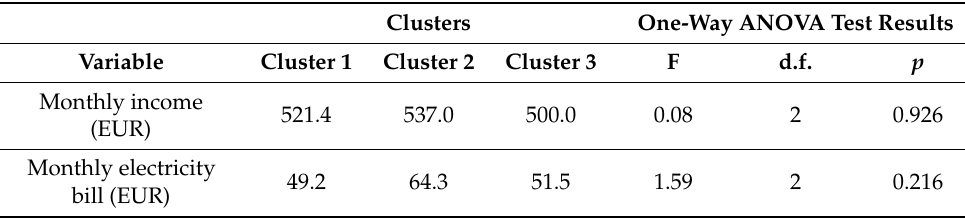
Table 7. One-way ANOVA test results of continuous socio-demographic variables between clusters in summer.